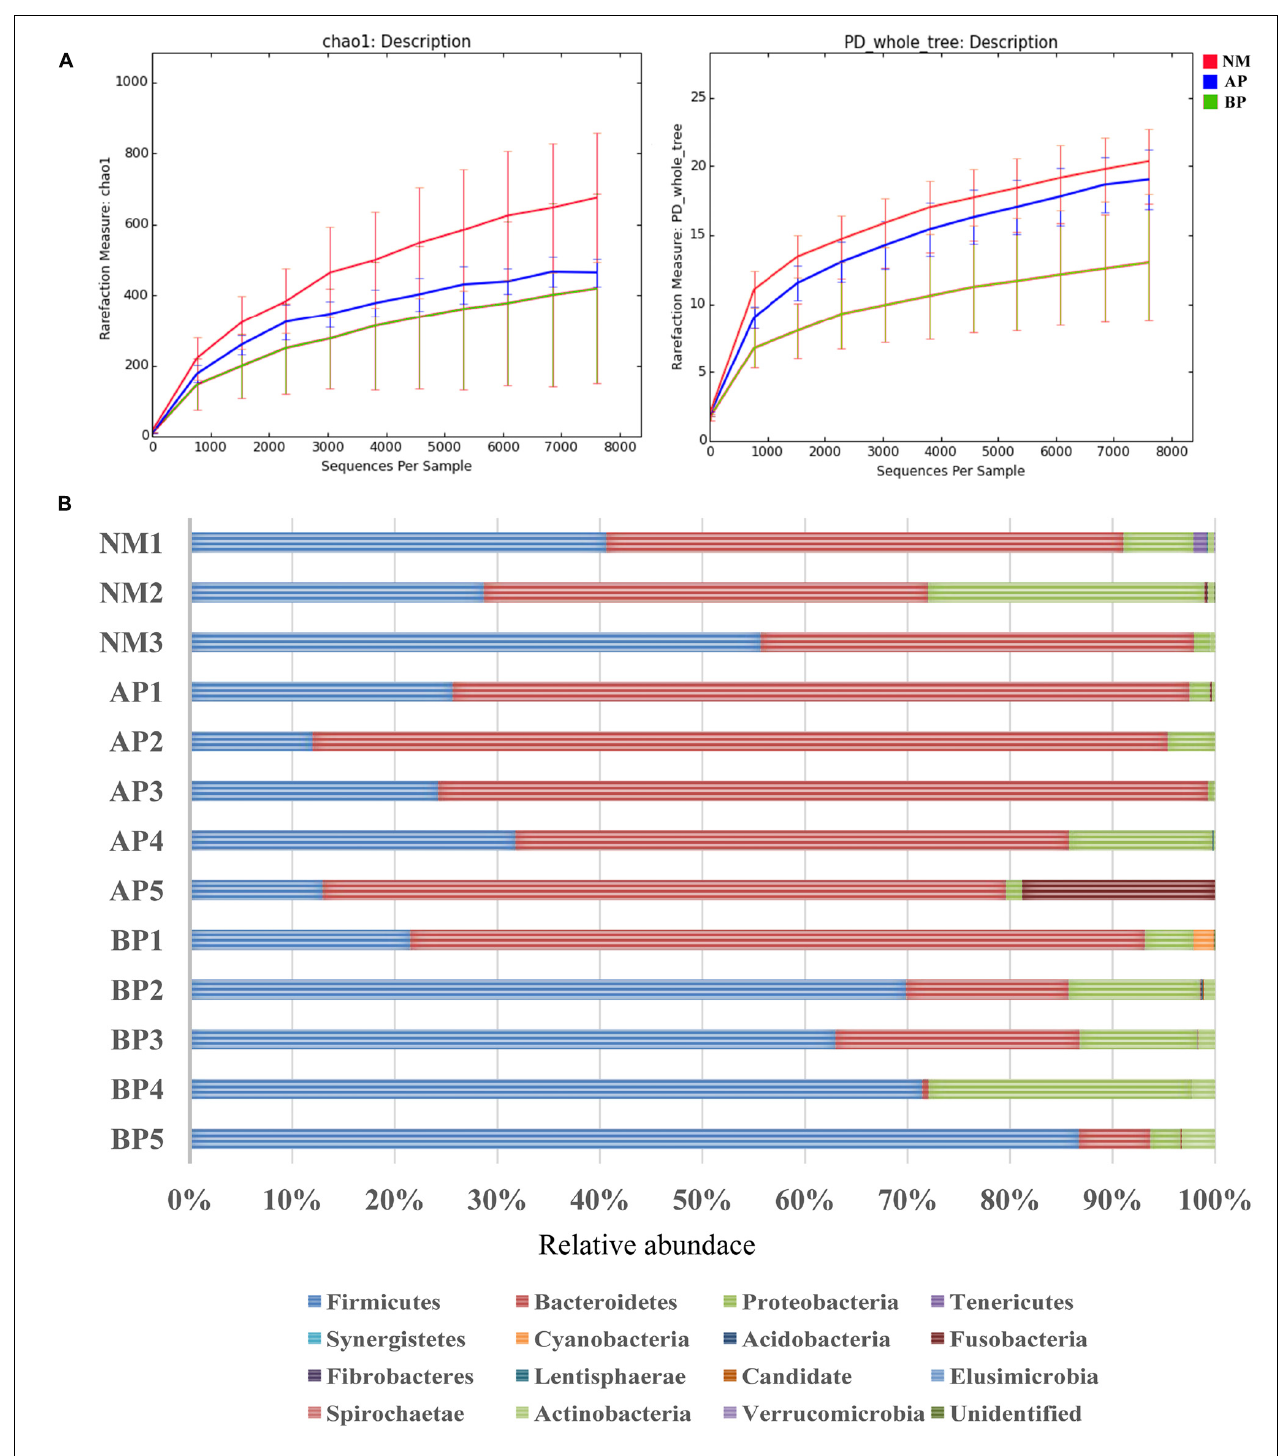
FIGURE 1 | Characteristics of fecal microbiota community from the study population. (A) Averaged number of richness (Chao 1) and diversity (PD, whole tree) of fecal samples from the subjects. The centered line represents the median value of NM (red), AP (blue), and BP (green), the top and bottom represent the 95th and 5th percentile of the data, respectively. (B) Relative abundance (%) of predicted bacterial phylum in the fecal microbiota community from cirrhotic patients and the normal.